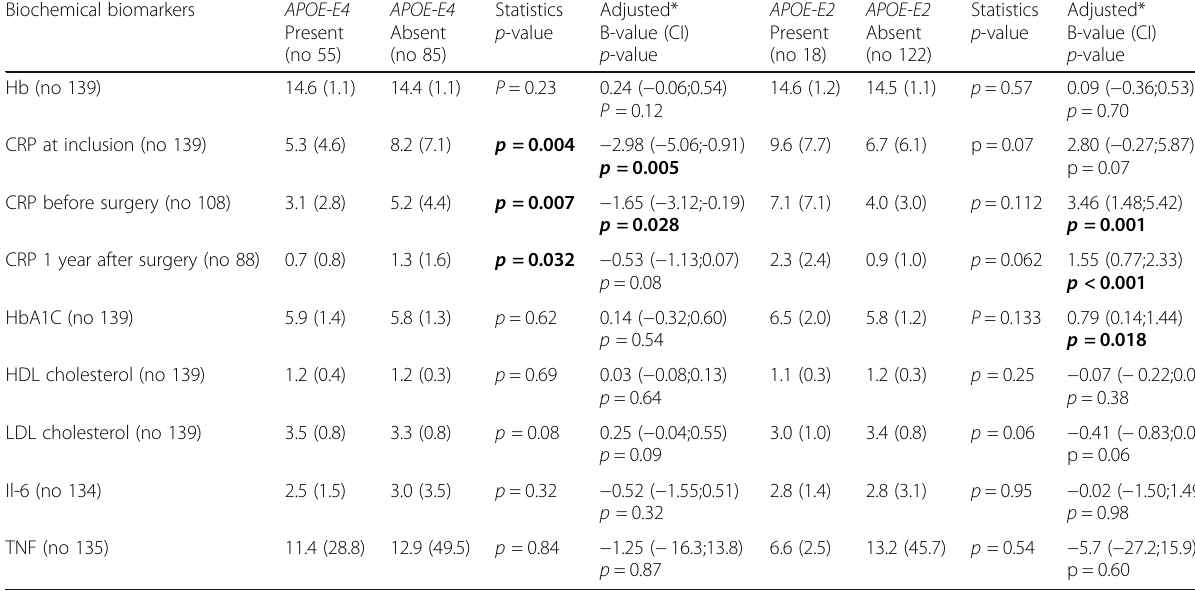
Table 3 Associations between biochemical biomarkers and APOE E4 and E2 variants Biochemical